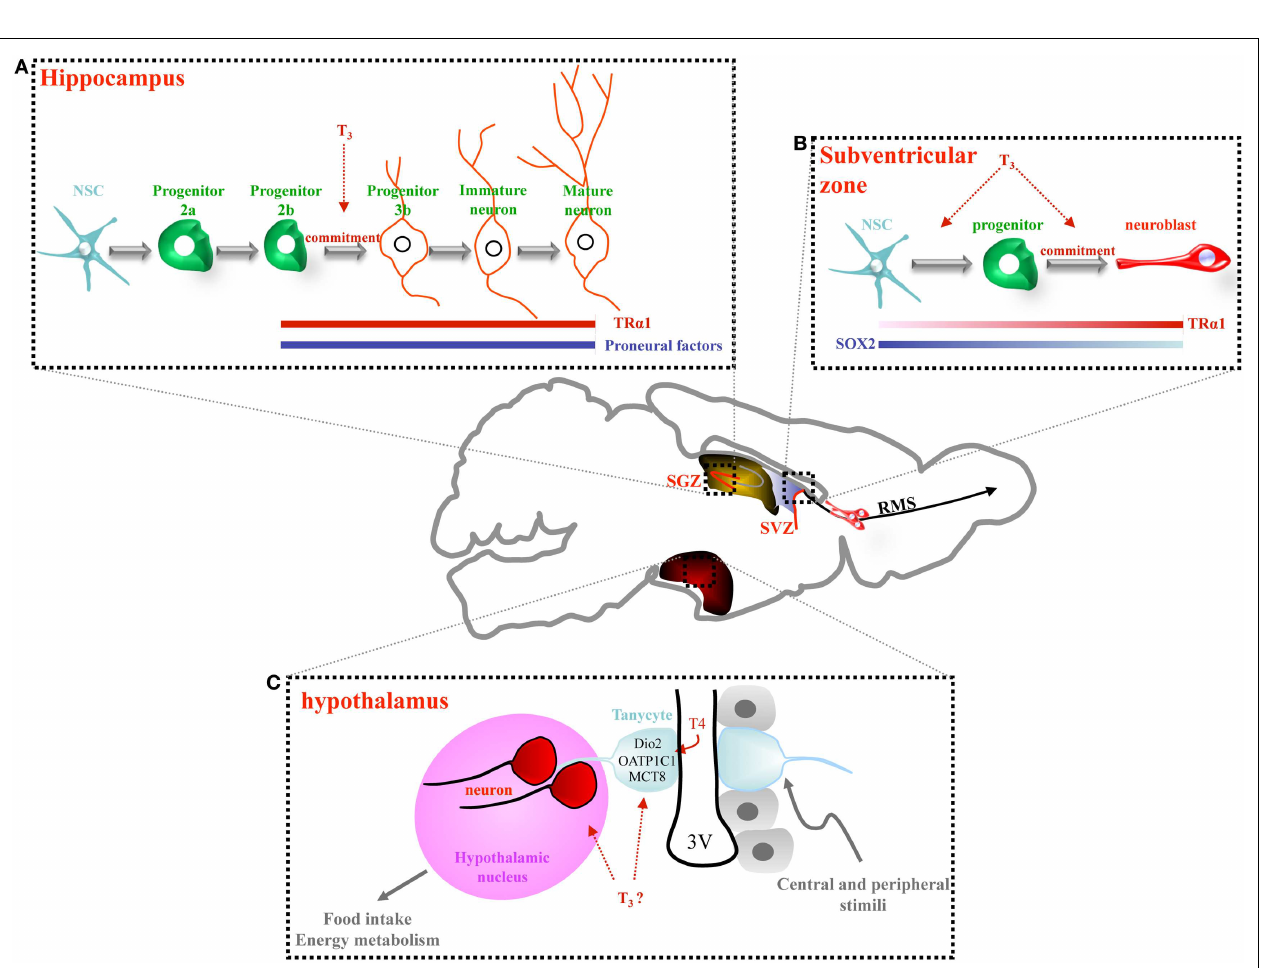
expressing high levels ofTR α 1 express low levels of SOX2 (neuroblasts).T 3 is involved in both progenitor proliferation and determination.TR α 1 overexpression in NSC and progenitors drives progenitor commitment toward a neuronal phenotype since cells overexpressingTR α 1 are found in clusters entering the RMS. (C) In the adult hypothalamus, the third ventricle is lined by ependymal cells (in gray) interspersed with tanycytes (in blue). Some of these tanycytes are stem cells.They possess a long process that projects into hypothalamic nuclei (in pink). Some recent data support the idea that tanycytes are able to generate new neurons that migrate into adjacent hypothalamic nuclei.Tanycytes express many key actors of theTH pathway (Dio2, OATP1C1, and MCT8) thus, facilitatingTH entry into the hypothalamus.These tanycytes could be considered as an “integrative platform” relaying central and peripheral signals to adapt adult neurogenesis to food intake and energy metabolism. A key role ofTH in the regulation of adult hypothalamic neurogenesis is an exciting